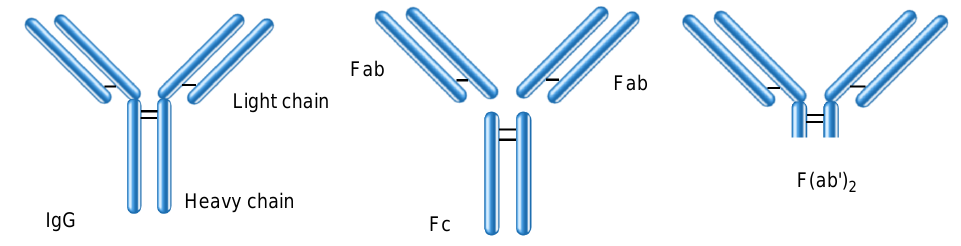
Figure 4. Structures of IgG and its fragments such as Fc, Fab, and F(ab′) 2 . Inflammatory bowel disease (IBD) is caused by excess tumor necrosis factor (TNF)- α in the lamina propria. V565 is an anti-TNF- α domain antibody developed for oral admin- istration that resists intestinal proteases such as trypsin, chymotrypsin, and pancreatin. Orally administered V565 was detected in the lamina propria because of the colonic mu- cosal barrier loss caused by TNF- α and in the serum, according to an in vivo assay using colitis mice; however, V565 was not detected in the colonic mucosal tissue and serum of naïve mice [22]. Thus, V565 is effective against ulcerative colitis (UC) and Crohn’s disease, which are classified as IBD. The formulation of coated mini-tablets was engineered for clinical use to prevent V565 from being degraded by gastric acid and pepsin in the stomach and to release it in the lower small intestine. At present, a phase 2 clinical trial of oral V565 (NCT02976129) and a phase 1 clinical trial of oral V565 in capsules (NCT03705117) were conducted for the treatment of Crohn’s